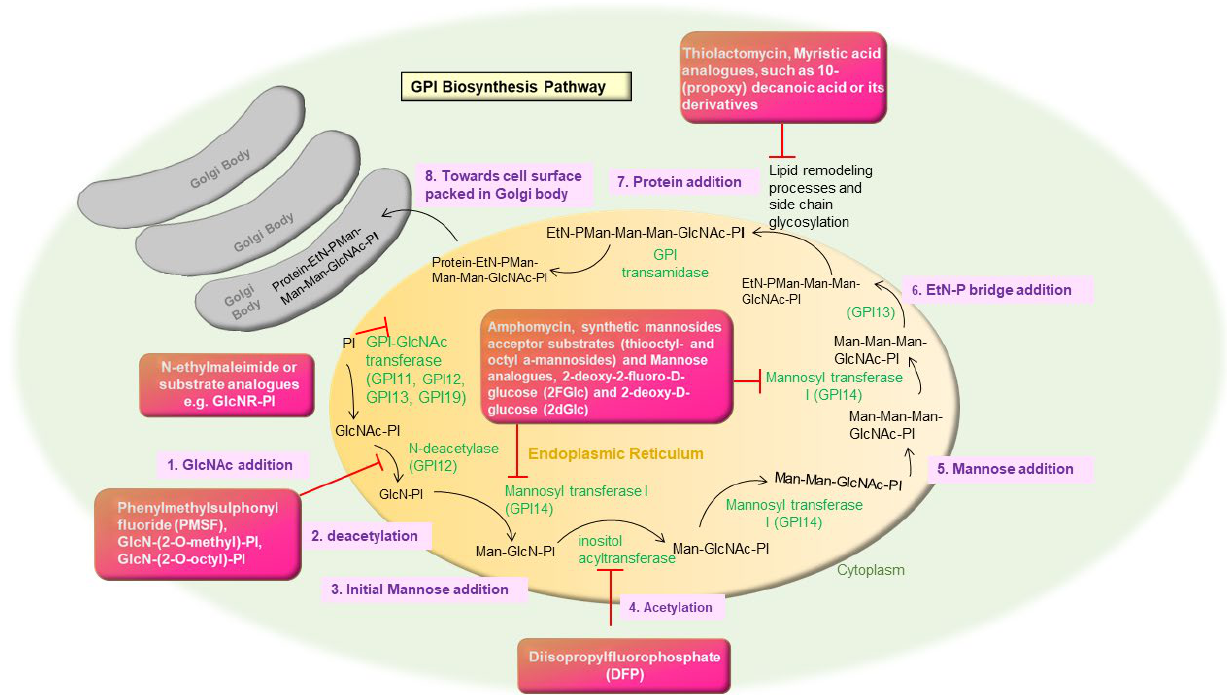
Figure 3. Inhibition of GPI biosynthesis pathway in Leishmania by different repurposed and/or potential drug candidates.